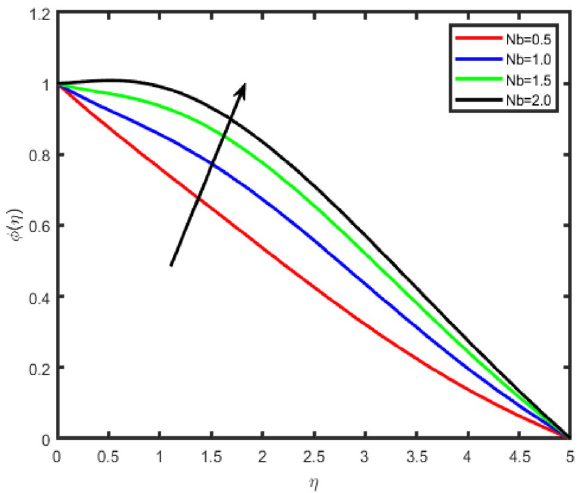
Figure 21. Effect of Brownian motion parameter (Nb) on concentration ϕ(η).